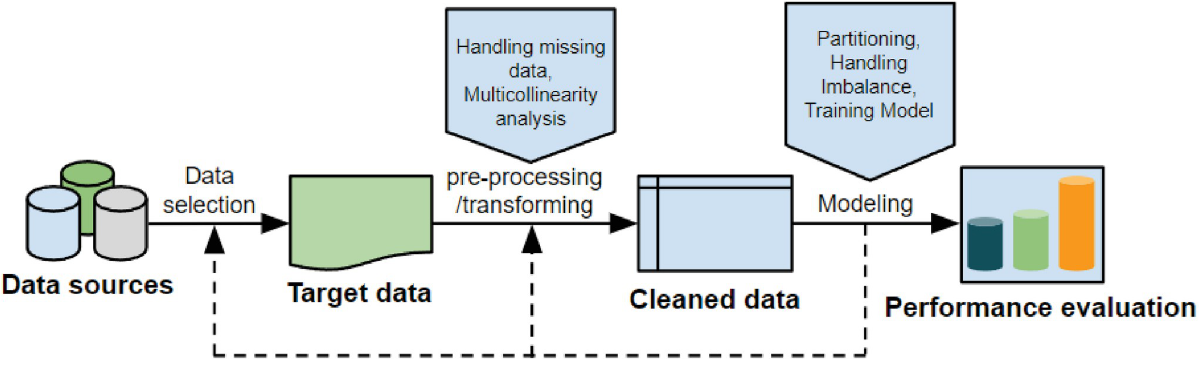
Fig 2. Modeling process